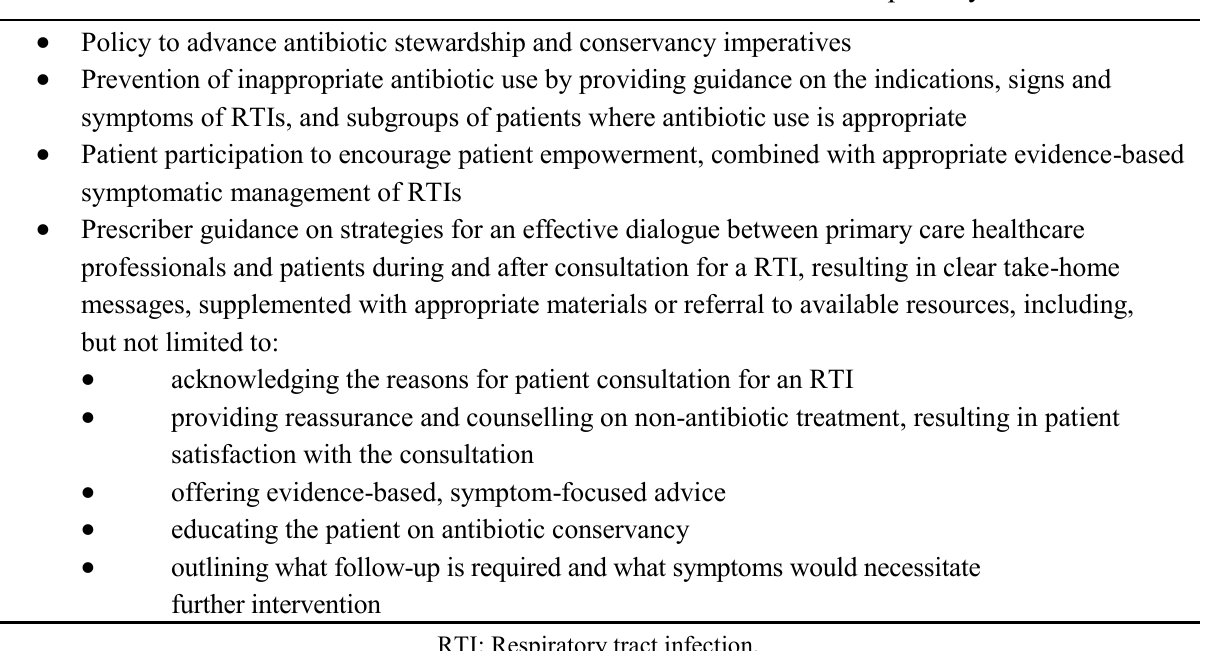
Table 1. Framework outline for the non-antibiotic treatment of acute respiratory tract